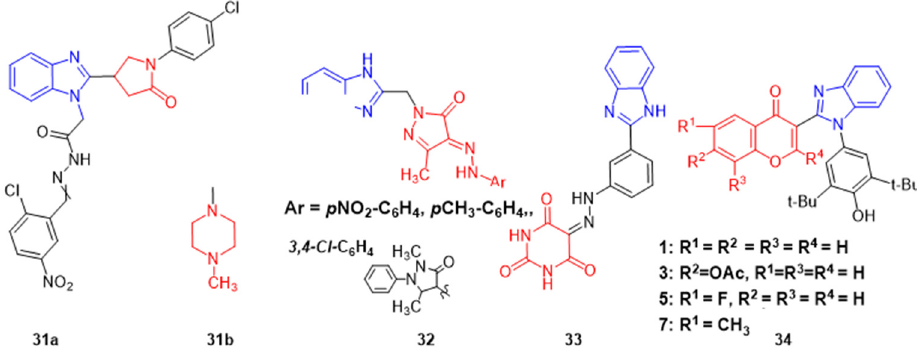
Figure 19. Triazole, thiadiazole, and oxadiazole–benzimidazole derivative structures. A series of benzimidazole compounds containing piperazine or morpholine cycle